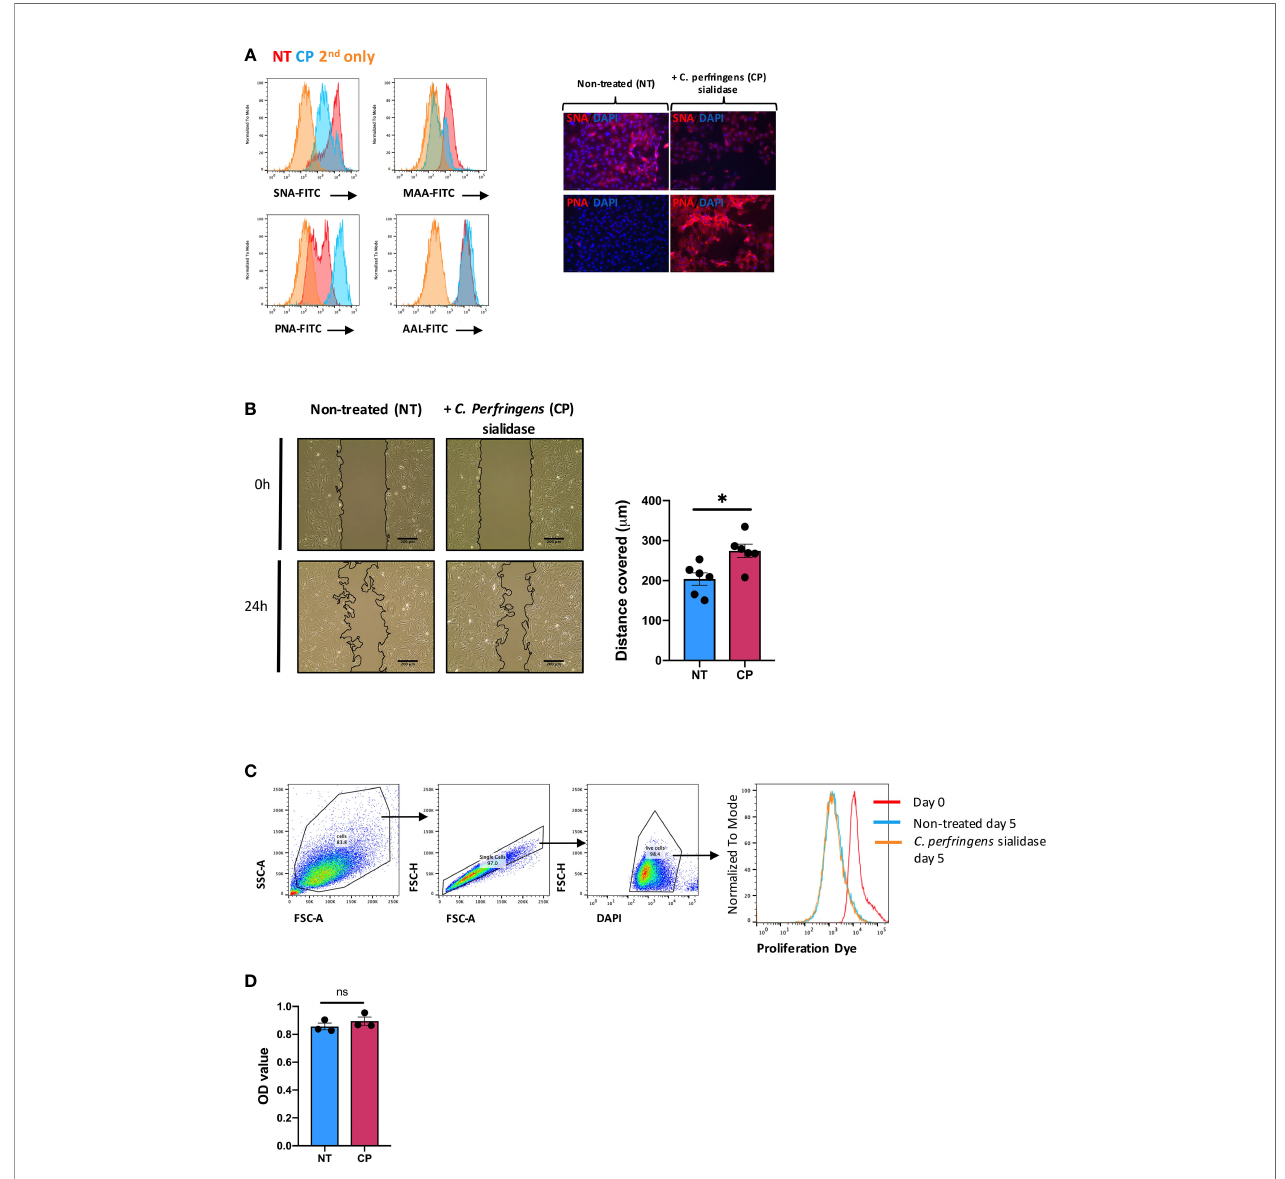
FIGURE 2 | In vitro desialylation enhances SFs motility. SFs isolated from naïve mice were cultured and expanded ex vivo . Cells were cultured to reach con fl uency and then treated with 0.1U/ml of C. perfringens sialidase (CP) for 1 hour to remove sialic acid from cell surface. (A) Control and sialidase-treated cells were stained with biotinylated lectins (SNA, MAA, PNA and AAL), followed by incubation with Alexa-647 streptavidin. Cells were then examined by fl ow cytometry to quantify lectin binding, as shown in histograms. Images were acquired in an EVOS ™ FL Auto microscope, showing SNA and PNA-stained cells. Error bars: 200 m m. (B) SFs were seeded in migration chambers and grown until monolayer con fl uence to conduct migration assays. Images show one representative experiment, including control and sialidase-treated naïve SFs when insert was removed (time 0, T0) and 24 hours after desialylation (T24). Superimposed black lines de fi ne the cell-free area, scale bar: 200 m m. Column graph show the mean migration distance of 5 independent experiments, showing non-treated (NT) and sialidase-treated (CP) cells. Error bars represent SEM, each dot represents one independent experiment (n = 5), *p < 0.05 by Mann-Whitney test. (C) SFs were labelled with proliferation dye eFluor 670 and analysed directly by fl ow cytometry (Day0) or treated with sialidase and maintained in culture for 5 days (Day5). Histogram shows one representative experiment. (D) Naïve SFs were seeded in 96-well plates, treated with sialidase and maintained in culture condition to assess cell viability and metabolomic activity using a colorimetric MTS assay. Each dot represents one independent experiment (n = 3) analysed in technical triplicate, error bars represent SEM, ns, non-signi fi cant, by Mann-Whitney